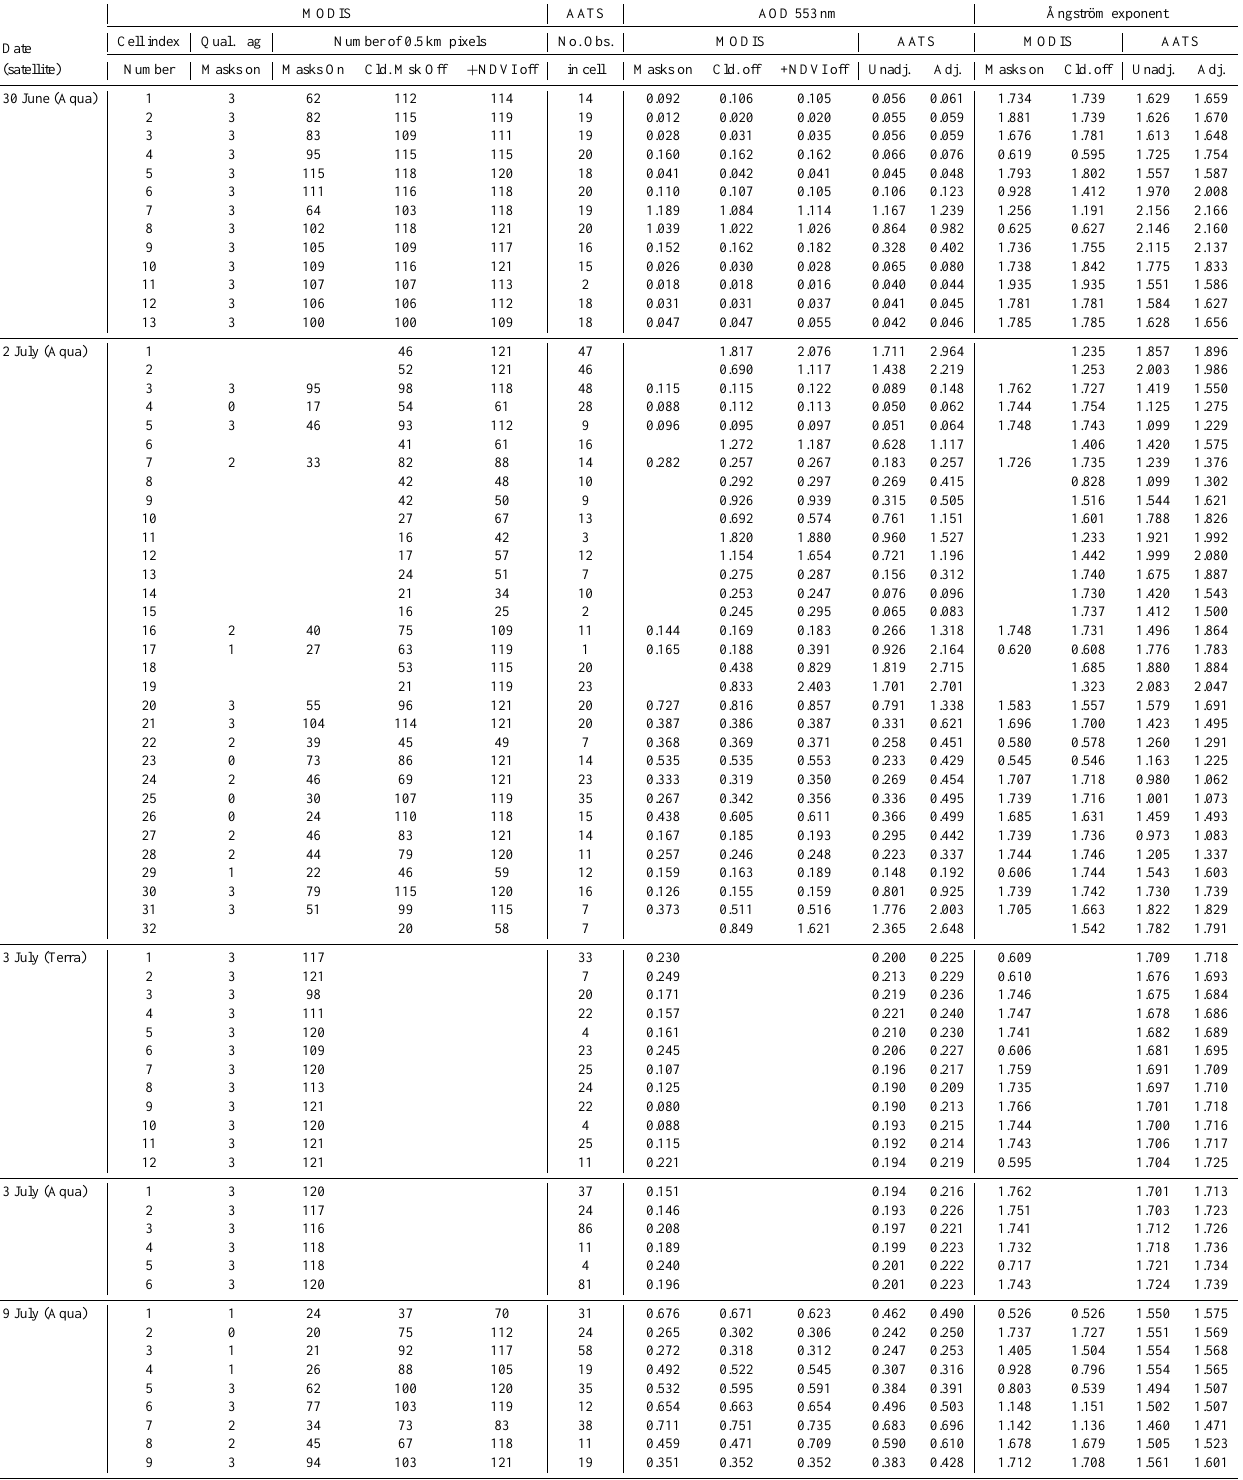
Table 1. Parameters for individual MODIS 10km aerosol retrieval grid cells, including MODIS and AATS AOD and Ångström exponents. MODIS AATS AOD 553nm Ångström exponent Cell index Qual. flag Number of 0.5km pixels Masks on Masks On Cld. Msk Off + NDVI